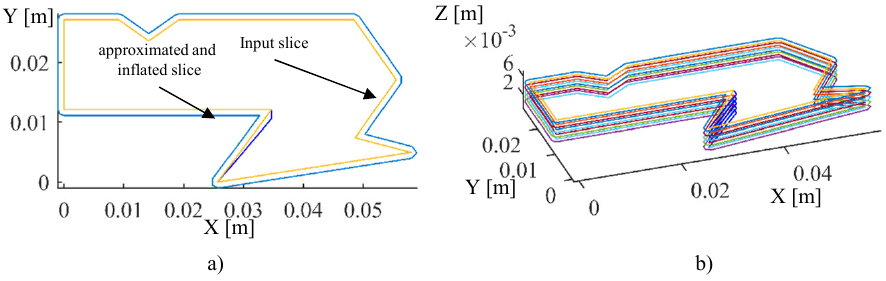
Figure 7. Approximation and expansion of the slice contour: ( a ) top view; and ( b ) side